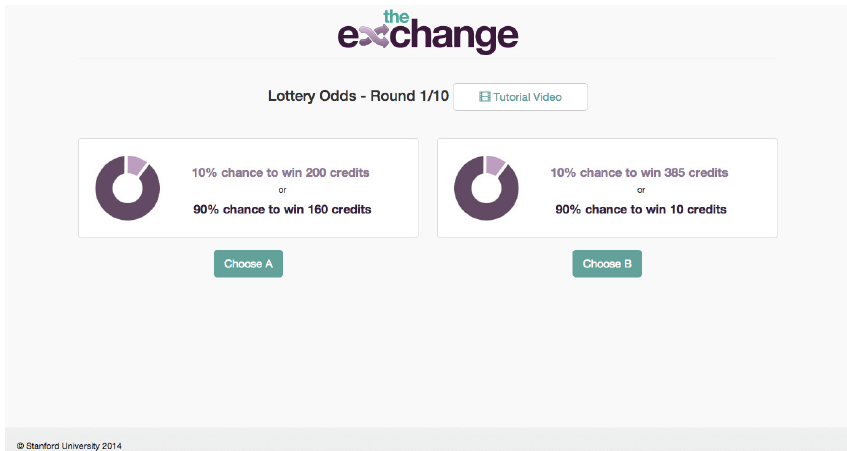
Figure 1. Screenshot of Lottery Odds (Risk Profile) Game